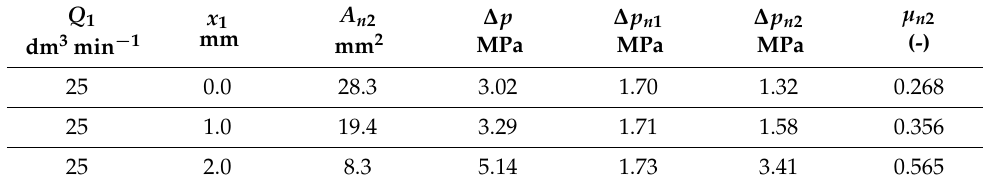
Table 4. The n 2 nozzle discharge coefficient µ n 2 calculation.